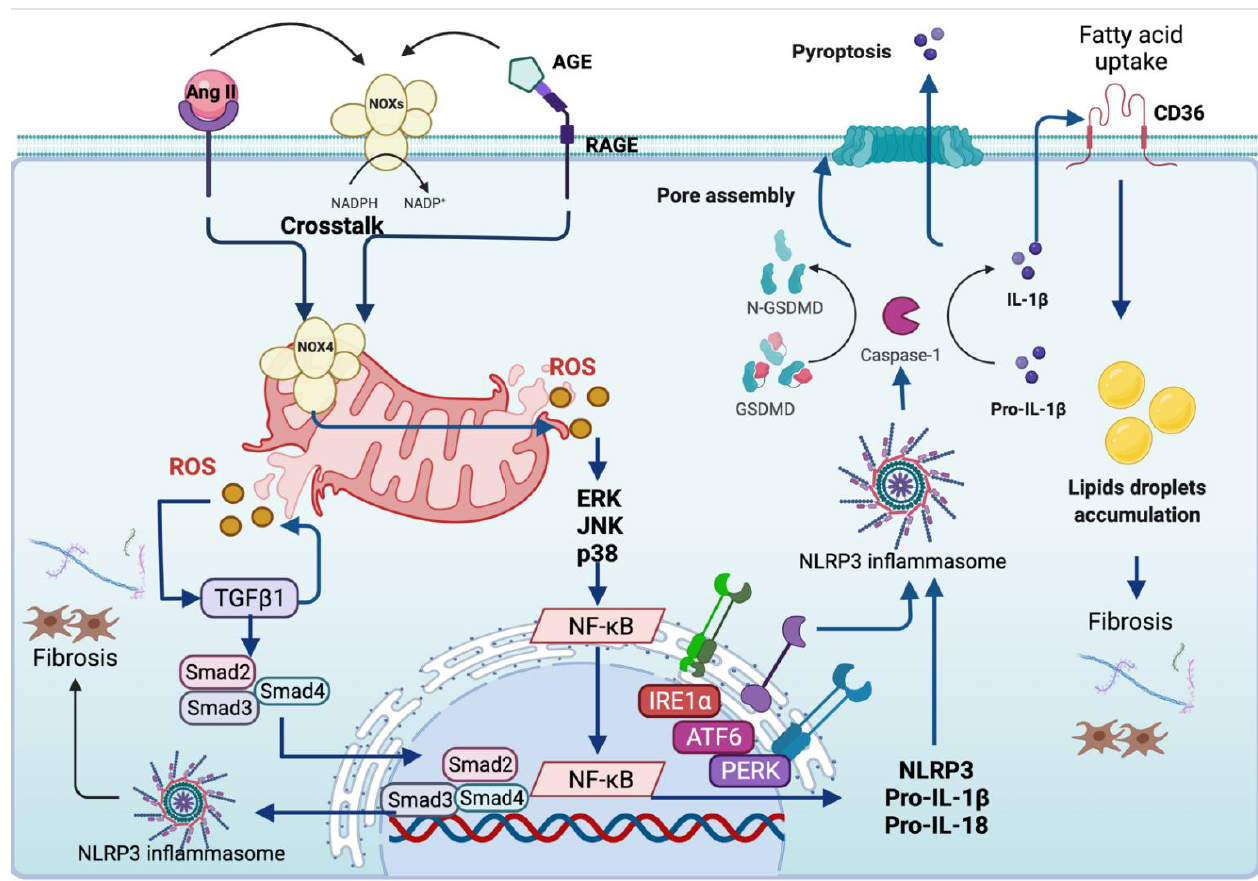
Figure 2. Activation of NOD-like receptor (NLR) family pyrin domain containing 3 (NLRP3) inflam- masome mediated by redox-signaling, mitochondria, and ER-stress during chronic kidney disease (CKD). The stimulation of NOXs by angiotensin II (Ang II) and the advanced glycation end products (AGE) generate crosstalk with the mitochondria, inducing ROS overproduction. These mechanisms are mediated by the interaction of Ang II and AGE with their receptors: angiotensin receptor 1 (ATR1) and AGE receptor (RAGE). ROS overproduction triggers activation of extracellular signal-regulated kinase (ERK), c-Jun N-terminal kinases (JNK) and p38, which activate nuclear factor κ -light-chain-enhancer of activated B cells (NF- κB), promoting the transcription of NLRP3, interleukin 1 β (IL - 1β) , and interleukin 18 (IL-18) to start inflammasome activation. Moreover, ROS induces transforming growth factor- β 1 (TGFβ1) activatio n, triggering the formation of the Smad complex, composed of Smad2, 3, and 4, which is translocated to the nucleus. In addition, TGFβ1 activation also generates ROS, promoting NLRP3 activation to induce fibrosis development. IL- 1β also leads to fibrosis by causing lipid droplets accumulation, mediated by inducing the upregulation of cluster of differentiation 36 (CD36), a receptor implicated in fatty acid uptake. Thus, fatty acid uptake trig- gers lipid droplet formation, inducing lipotoxicity and later promoting fibrosis. Endoplasmic retic- ulum stress also activates NLRP3 by generating ROS. NLRP3 inflammasome induces pyroptosis in which caspase-1 cleaves pro-IL- 1β to form IL - 1β, the active form, and cleaves gasdermin (GSDMD) proteins to produce an N-terminal domain (GSDMD-N). Thus, GSDMD-N can oligomerize and form pores in the plasmatic membrane, triggering increased osmotic pressure, followed by cell swelling and bursting. Figure created using BioRender (Toronto, ON, Canada).